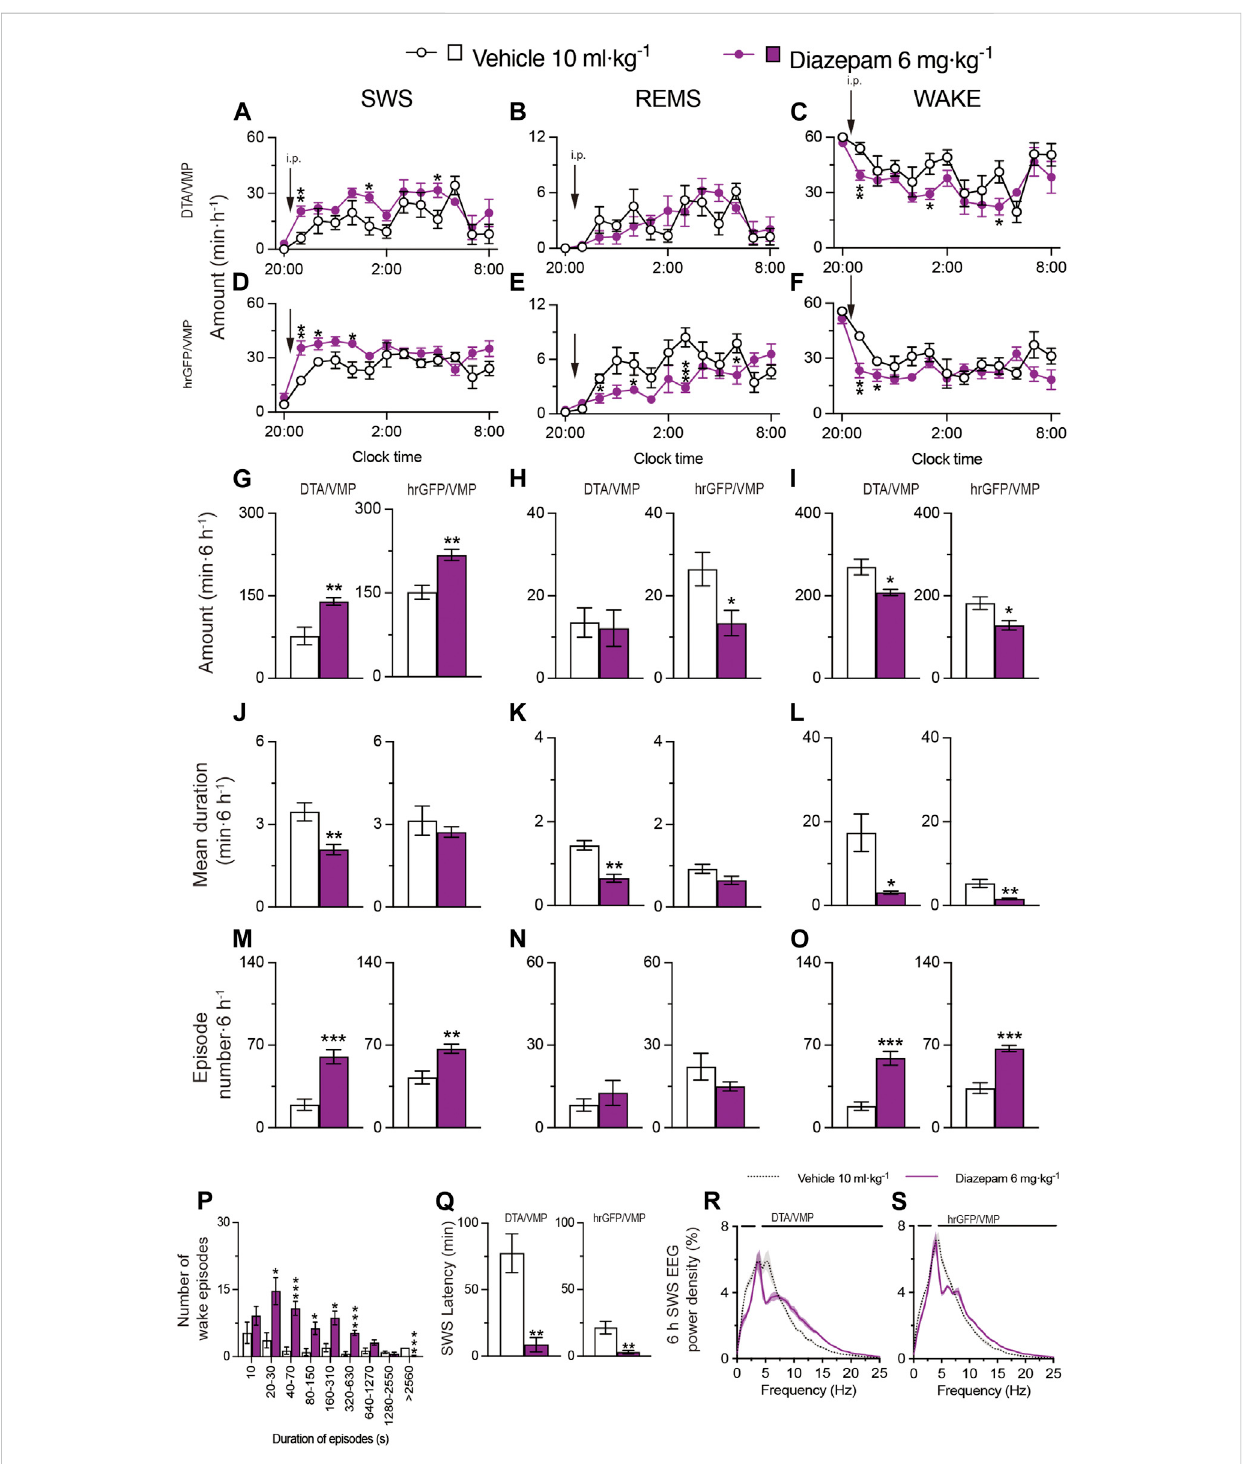
FIGURE 5 Intraperitoneal injection of benzodiazepine induces sleep in mice with mania-like behavior. (A – O) Time course (A – F) , total amount (G – I) , mean duration (J – L) ,andepisodenumber (M – O) ofSWS,REMS,andwakefulnessinVGAT-Cre DTA/VMP andVGAT-Cre hrGFP/VMP miceafteradministeringvehicleor diazepam. (P) Wake episode spectrum in VGAT-Cre DTA/VMP mice. (Q) Latency to sleep onset in VGAT-Cre DTA/VMP and VGAT-Cre hrGFP/VMP mice after administering vehicle or diazepam. (R,S) SWS EEG power density for 6 h after injection of vehicle or diazepam into VGAT-Cre DTA/VMP (R) and VGAT- Cre hrGFP/VMP (S) mice. Bars indicate statistical signi fi cance ( p < 0.05). Data (n = 6/group) are presented as mean ± SEM. Signi fi cance levels are indicated as * p < 0.05, ** p < 0.01, and *** p <